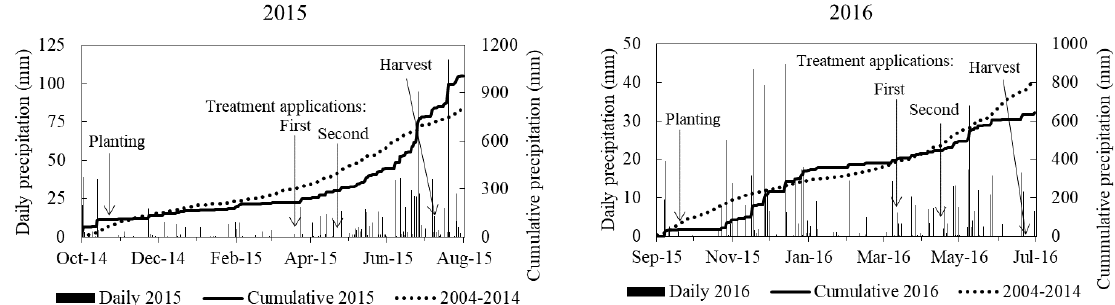
Figure 1. Precipitation history for the study years of 2015 and 2016. The bars represent daily precipitation during the study year, the solid line represents the cumulative precipitation during the study year, and the dotted line represents the average cumulative precipitation from 2004 to 2014.